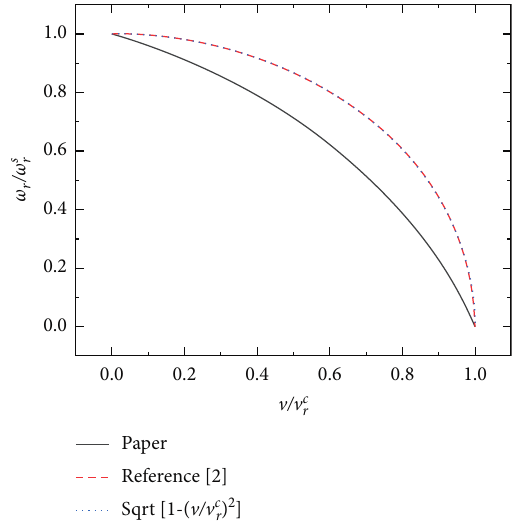
Figure 7: The change curve of natural frequency ratio with liquid velocity ratio of the pipe. Figure 5: The change curve of first 3 orders of related time function